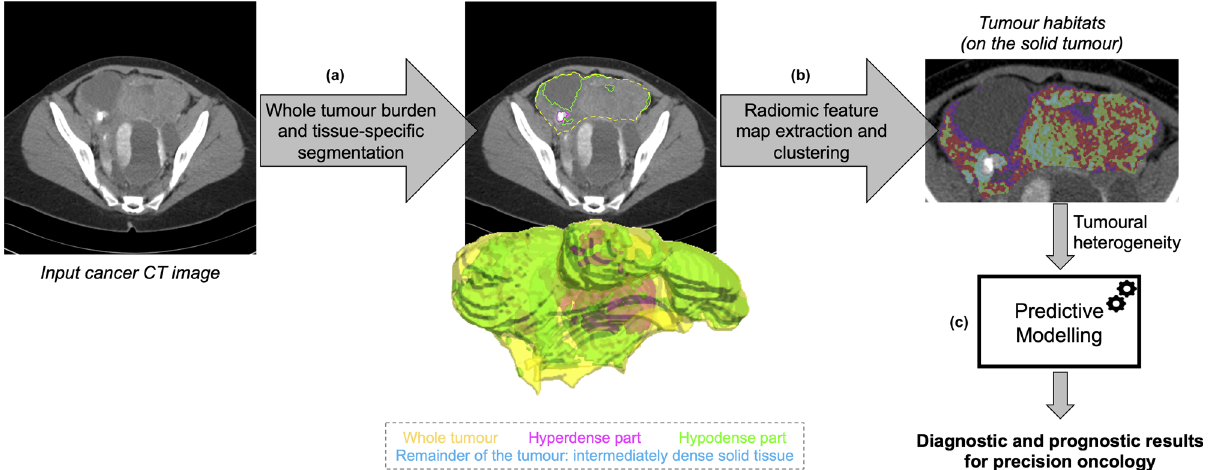
Fig. 4 Machine Learning (ML) in a radiomics pipeline for evaluating tumour habitats. a Whole tumour segmentation and identi fi cation of physiologically different regions by means of tissue-speci fi c sub-segmentation on computed tomograhy (CT) imaging (e.g. using 3D volume rendering of tissue components with colour codes shown below). This is followed by b voxel-based radiomic feature map extraction and unsupervised clustering for tumour habitats considering the most clinically relevant region. Next, c quantitative measurements and inferred tumoural heterogeneity metrics are processed by ML predictive models to yield diagnostic and prognostic results. In this example, we have used CT images from a patient with metastatic ovarian cancer with a representative omental